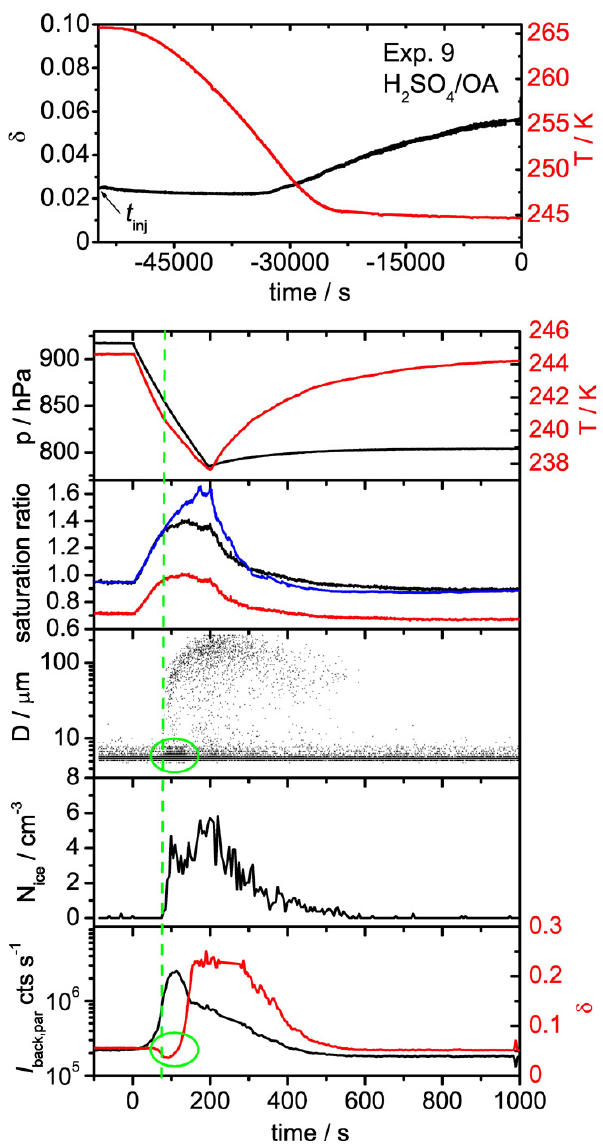
Fig. 17. Top part: Time series of the depolarisation ratio δ (black line) and the mean AIDA gas temperature (red line) after spray- ing ternary H 2 SO 4 /OA/H 2 O solution droplets with an OA:H 2 SO 4 mass ratio of 3.43:5 (Exp. 9) into the aerosol vessel at t = − 55000s ( t inj ) . After aerosol addition, the chamber was cooled from 265 to 244K, see text for details. Bottom part: Time series of various AIDA records during the first expansion cooling cycle from Exp. 9 that was started at 244K. The individual panels show the same mea- surements as in Fig.